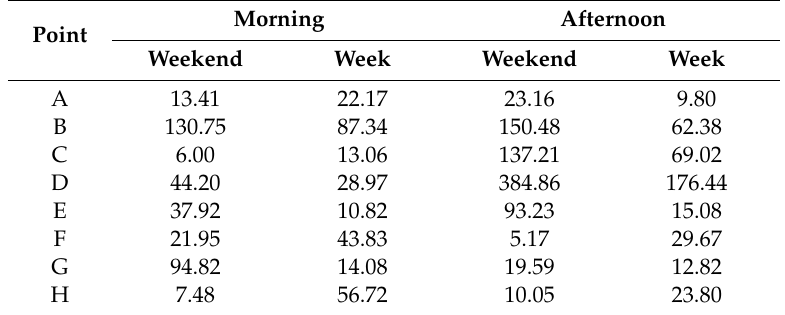
Table 3. Measures recorded around building C (classrooms and laboratory), values expressed in μ W/m 2 .